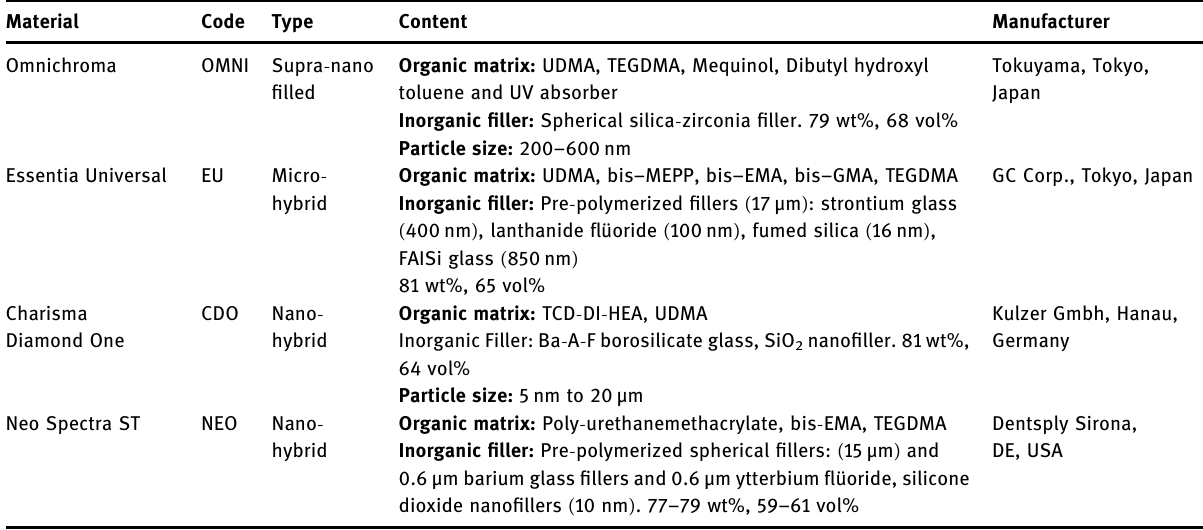
Table 1: Type, content, and manufacturer of the resin - based composite materials Material